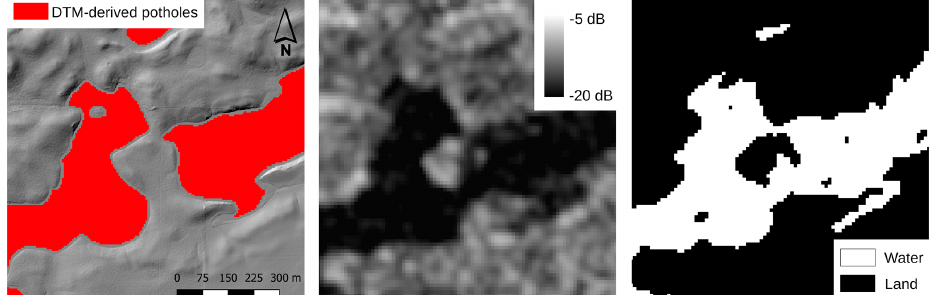
Figure 4. The left panel shows the DTM hillshade and derived potholes, the middle panel displays the Sentinel-1 σ 0 the right panel outlines the derived open water extent.